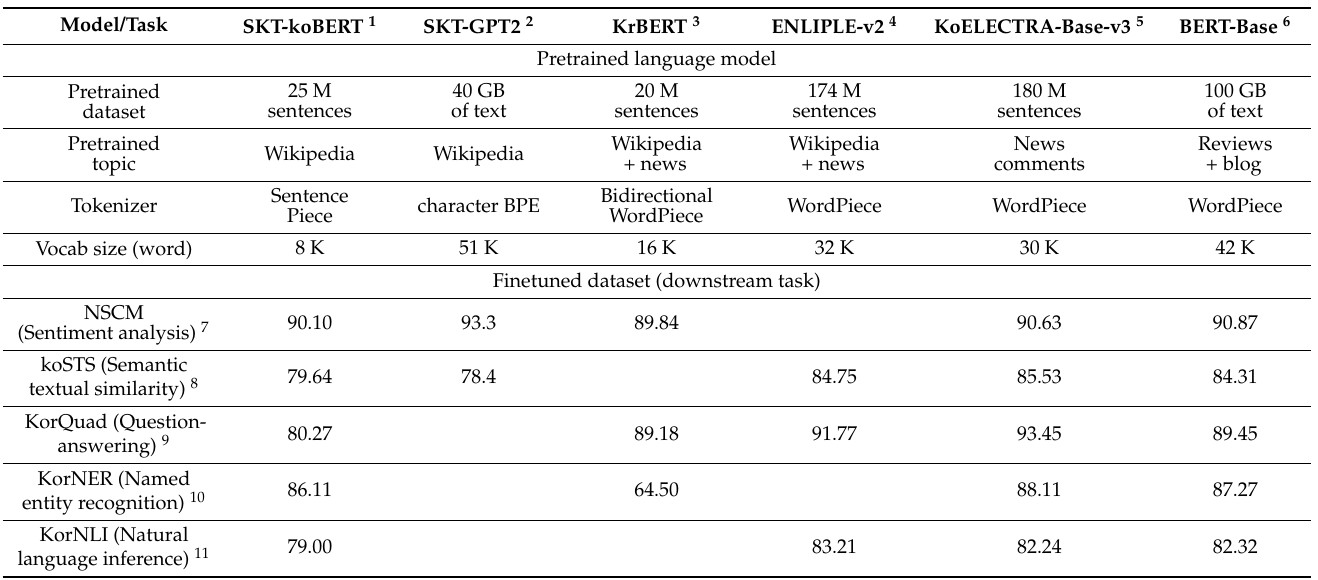
Table 1. Performance of Korean pre-trained models on various downstream